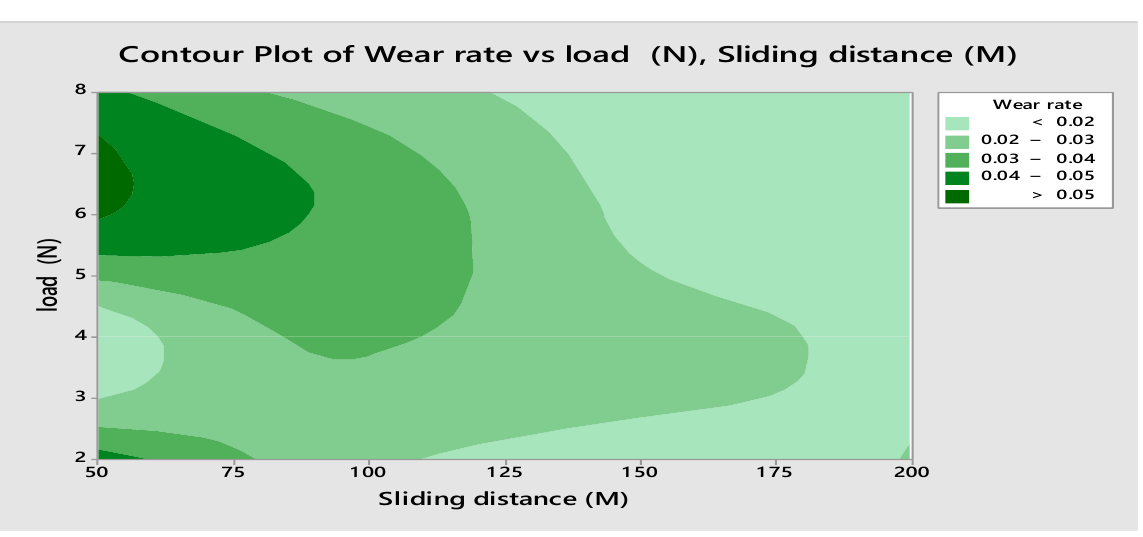
Figure 4: Wear Map 1 shows the lowest wear rate at sliding distance, 200m/s and the load of 4N